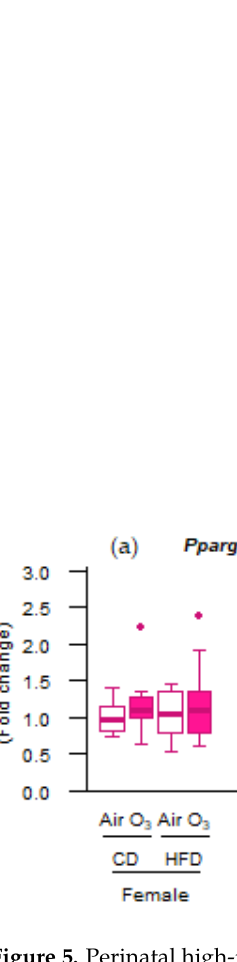
Figure 5. Perinatal high-fat diet (HFD) or acute ozone exposure did not affect the molecular regulation of mitochondrial biogenesis. ( a ) Ppargc1a , ( b ) Ppargc1b , and ( c ) Tfam mRNA levels were measured within two hours after exposure to filtered air or ozone in the lungs of female and male offspring from dams fed a perinatal control diet (CD) or HFD. Data are presented as boxplots. Statistical analysis by two-way ANOVA with a Holm–Sidak post-hoc test. n = 9–10 per group. O 3